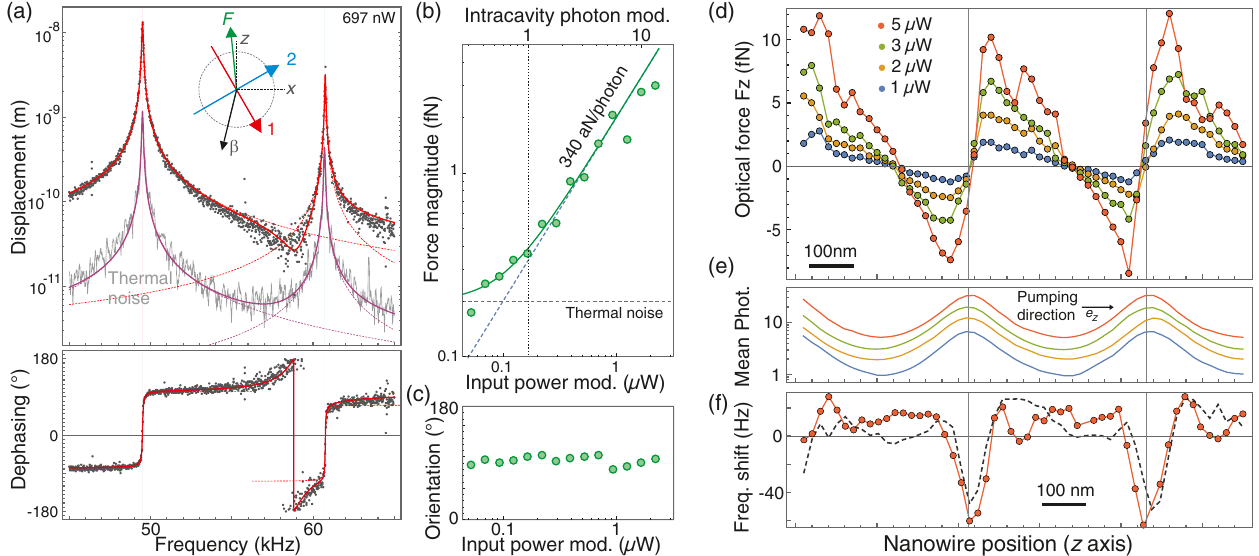
FIG. 3. Nanomechanical measurement of the intracavity optical force. (a) Thermal noise (gray line, 30-Hz resolution bandwidth) and response measurements (dots) measured with the red probe laser ( 5 μ W), providing a projective measurement of the nanowire vibrations along the e β axis (inset), for a cavity locked at resonance at position ⊙ in Figs. 2(d) and 2(e). The response measurements are realized with a vectorial network analyzer, whose output channel serves to intensity modulate the infrared cavity pump laser. The phase difference is measured between the recorded displacement and the generated intensity modulation. Fitting of the data (see text) allows us to determine the eigenmode orientations e and the instantaneous optical force vector. (b,c) Evolution of the magnitude and orientation 1 ; 2 ) of the optical force vector plotted with respect to the amplitude of the intracavity-photon-number modulation (with respect to e x ( δ h a † a i ), down to unity, and to the corresponding input power modulation amplitude (using P 0 ¼ 3 μ W, which corresponds to 17 intracavity photons at that position; see Appendix D). (d) Dependence of the instantaneous force F with the position along the optical z axis for increasing input powers (70% modulation depth). The nodes of the electromagnetic modes are indicated as vertical lines and correspond to maxima in the transmission plots shown in (e), expressed in terms of mean intracavity photon number. (f) Measured relative frequency shifts (dashed lines) obtained for 5 μ W compared to the shifts expected from the measured optical-force-field Þ ∂ M F gradients ð − 1 = 2 Ω (red z z m eff